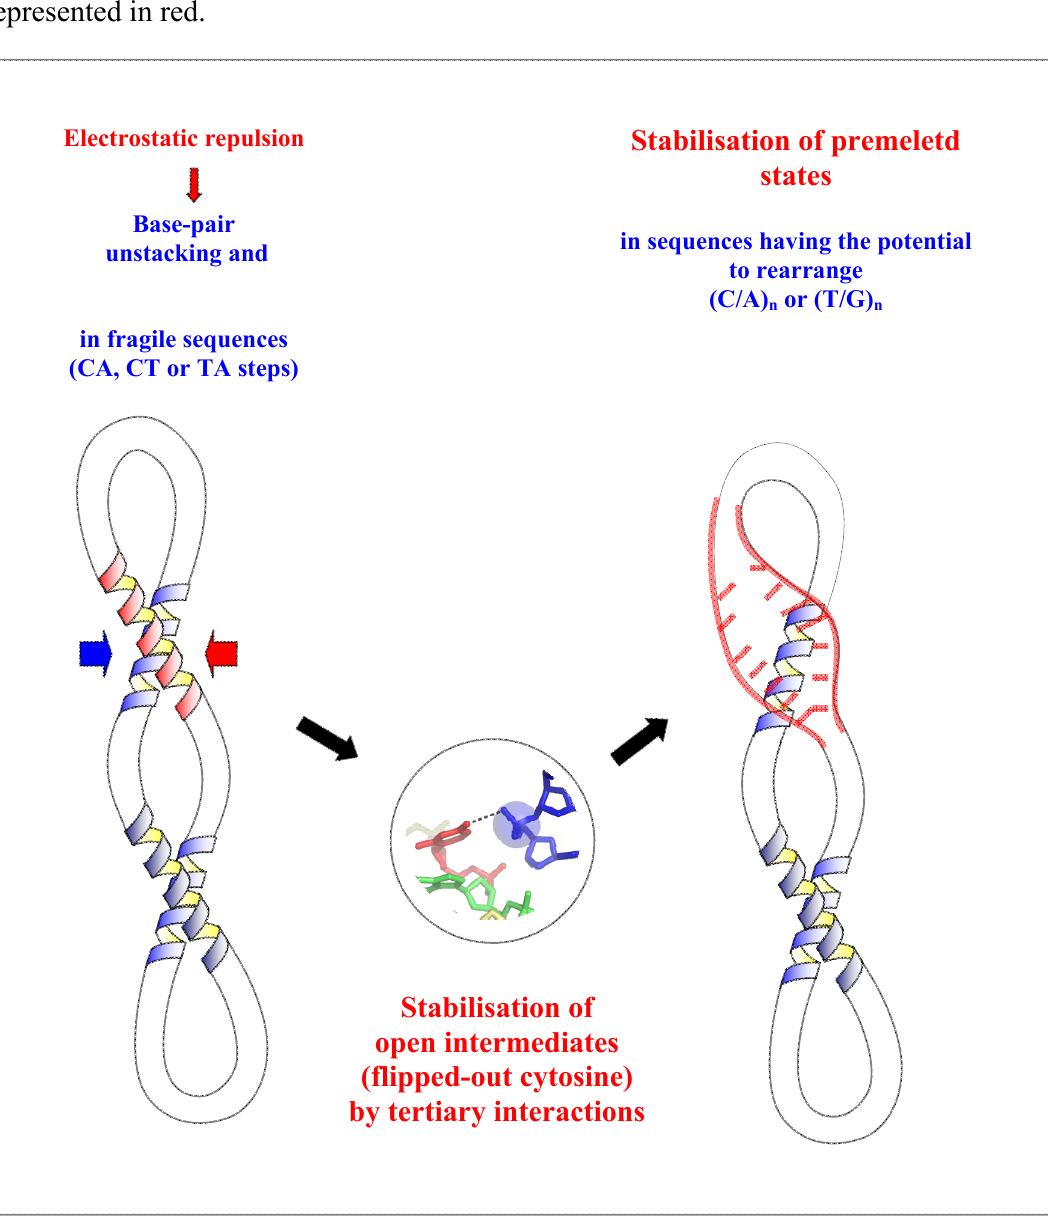
Figure 7. Model of a molecular mechanism of DNA-directed base pair opening. The close approach of two DNA segments in supercoiled DNA or higher-order structure can induce the initiation of strand separation in specific sequences such as (C/A) represented in